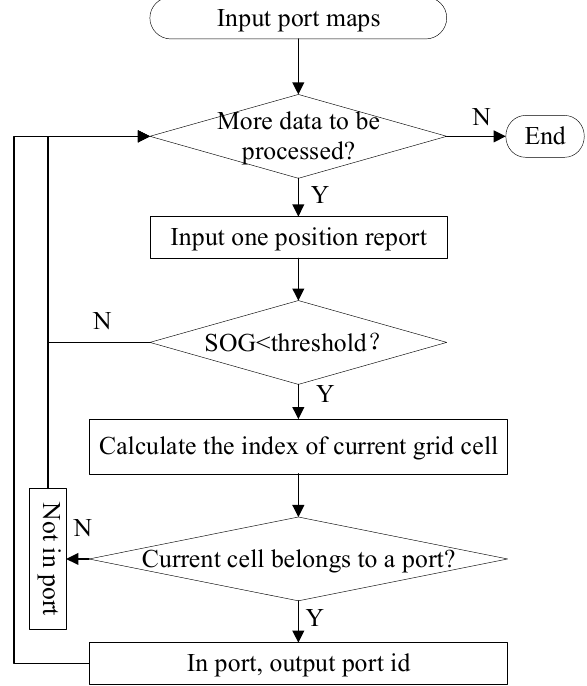
Figure 6. Flowchart of port call detection with port area database. The map of a port is in the form of grid cell set.